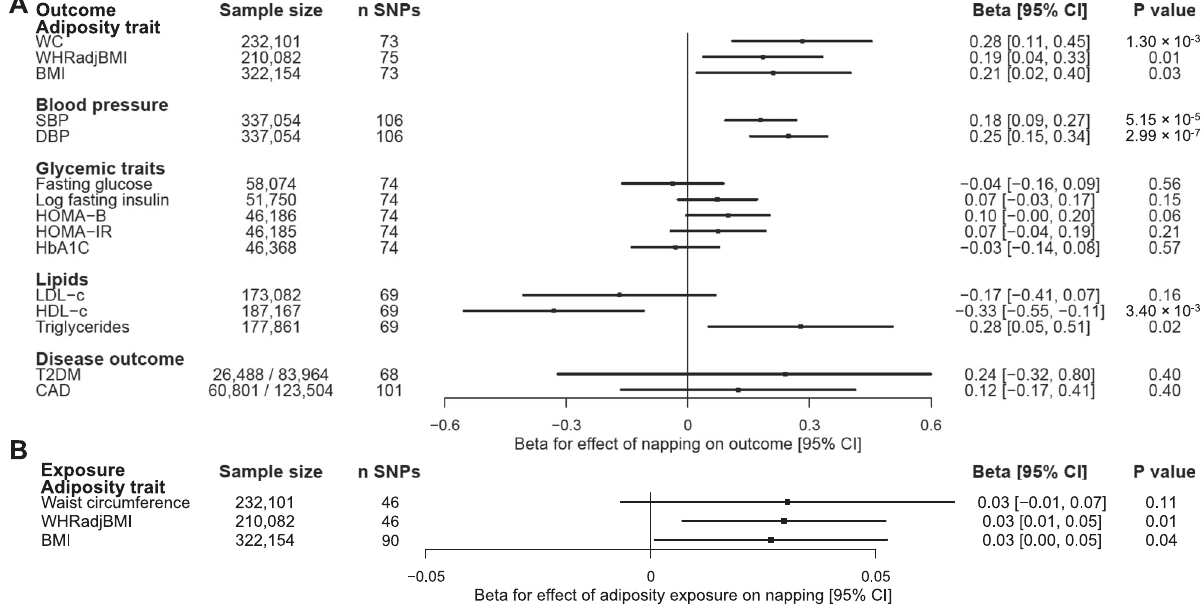
Fig. 5 Mendelian randomization supports a causal effect of daytime napping on higher blood pressure and waist circumference. The MR estimates were calculated using the random-effects inverse-variance weighted method and represent the effect of a one-unit increase in napping category (never, sometimes, usually). Sample sizes re fl ect either the total sample size (for continuous outcomes) or number of cases and controls (for binary outcomes). A IVW effect estimates for more frequent daytime napping on cardiometabolic outcomes and risk factors. A unit increase in the adiposity and blood pressure measurement represents a standard deviation increase in the corresponding trait. Black boxes show effect estimates, and surrounding lines display 95% con fi dence intervals. All P values are two-sided. B IVW effect estimates for the effect of adiposity traits on daytime napping frequency. Black boxes show effect estimates, and surrounding lines display 95% con fi dence intervals. All P values are two-sided. * signi fi cant at Bonferroni-corrected alpha threshold and robust in sensitivity analyses. BMI body-mass index, CAD coronary artery disease, CI con fi dence interval, DBP diastolic blood pressure, HOMA homeostatic model assessment of insulin resistance, HOMAB homeostasis model assessment of β -cell function, LDL low-density lipoprotein, HDL high-density lipoprotein, OR odds ratio, SBP systolic blood pressure, SNP single-nucleotide polymorphism, T2DM type 2 diabetes mellitus, WC waist circumference, WHRadjBMI waist-to-hip ratio adjusted for BMI. 2RTRCH1RTRCH Outcome